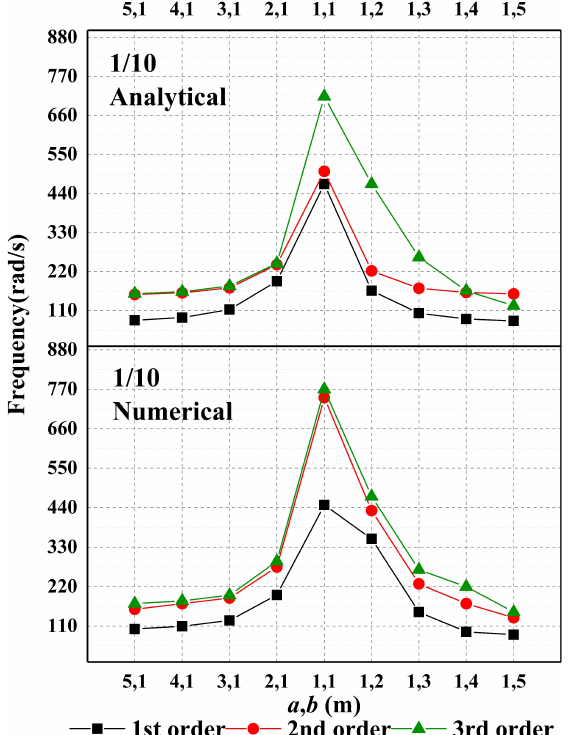
Figure 11: Comparison of natural frequencies under different length width ratios when the rise span ratio is 1/10